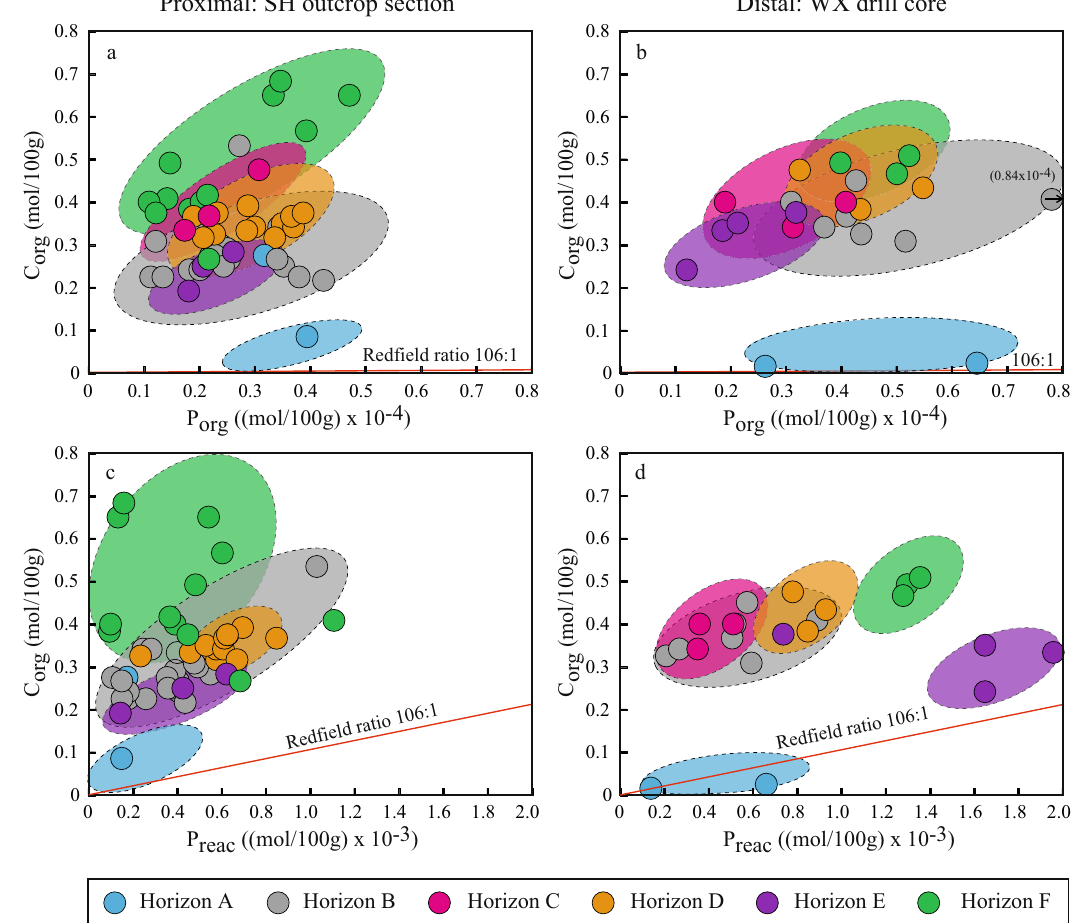
Fig. 2 Molar C org /P org and C org /P reac ratios for the proximal Shuanghe (SH) outcrop section and the distal Wuxi (WX) drill core. a C org /P org for the proximal section; b C org /P org for the distal section; c C org /P reac for the proximal section; d C org /P reac for the distal section. Horizons A – F are as identi fi ed in Fig. 1, and are broadly grouped into ranges (larger oval groupings). Samples that fall outside of the Horizon A – F groupings on the C org /P reac plots re fl ect transitional redox conditions at the boundary between different horizons. These samples appear to have been affected by diagenetic over-printing as the redox state of the overlying water column evolved, and thus are not included in the modelling analysis. The red lines represent the molar Red fi eld ratio of